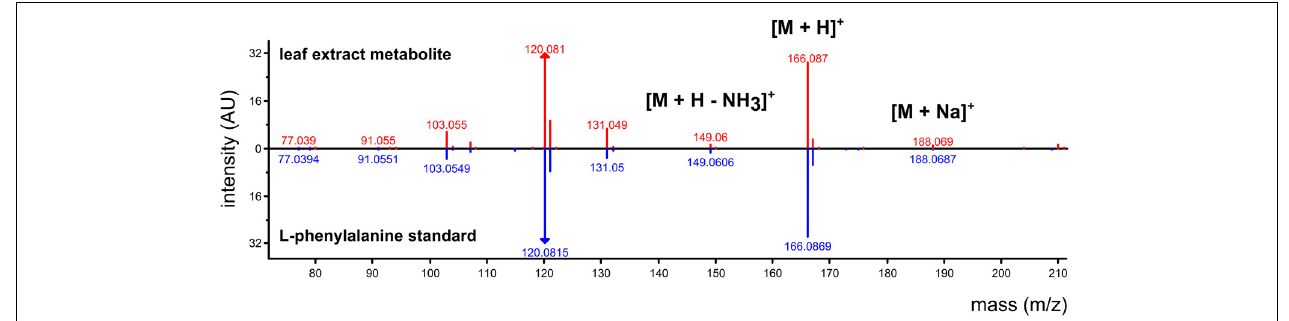
FIGURE 3 | Annotation of an LC-ESI-MS detected (positive ionization) metabolite using a metabolite database for non-targeted MS acquisition. In a non-targeted workflow, each mass signal is treated as an independent variable for statistical